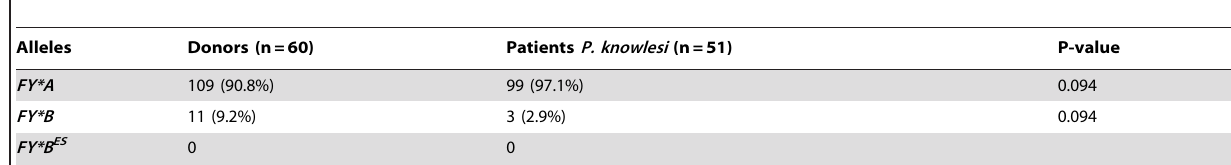
Table 3. Comparison of allelic frequencies between blood donors and P. knowlesi infected patients.